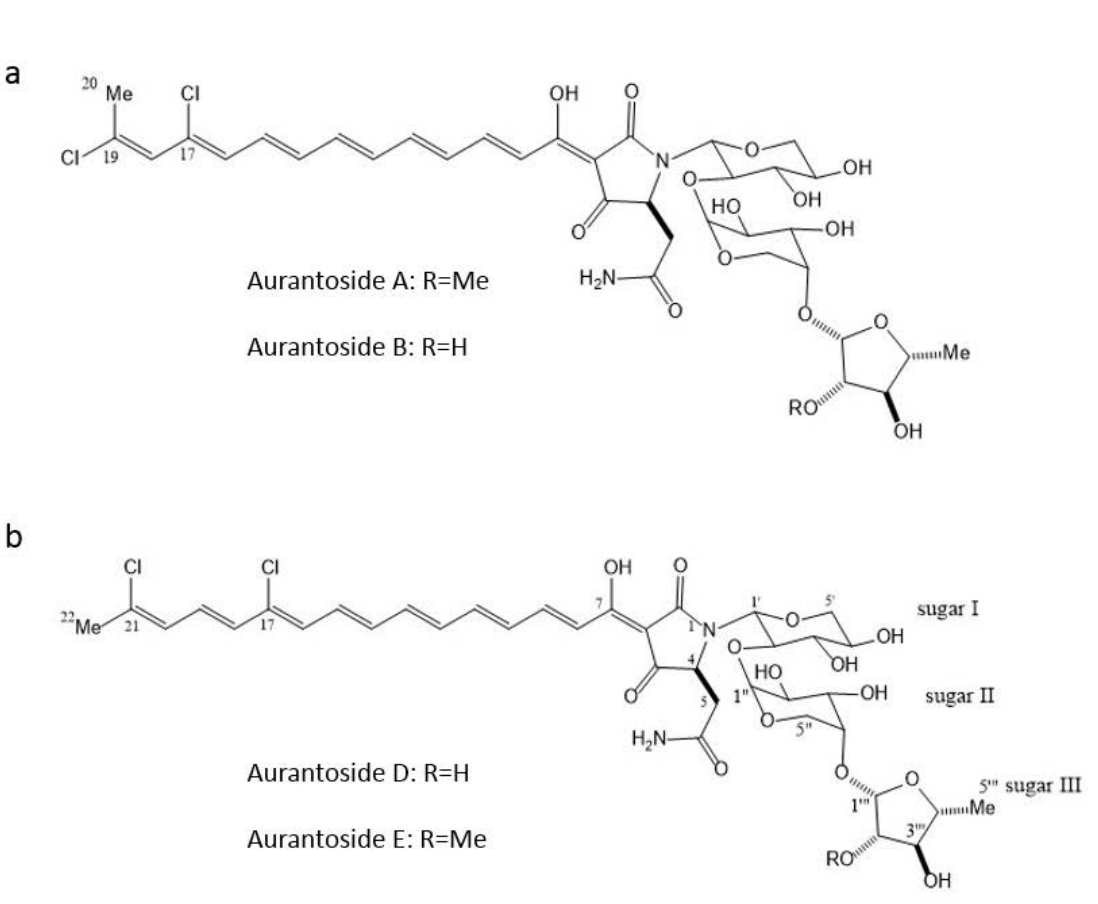
Figure 2. Chemical structures of compounds from marine sponges with antifungal activities against A. fumigatus. ( a ) Aurantosides A & B, ( b ) Aurantosides D & E, and ( c ) Microsclerodermin A &